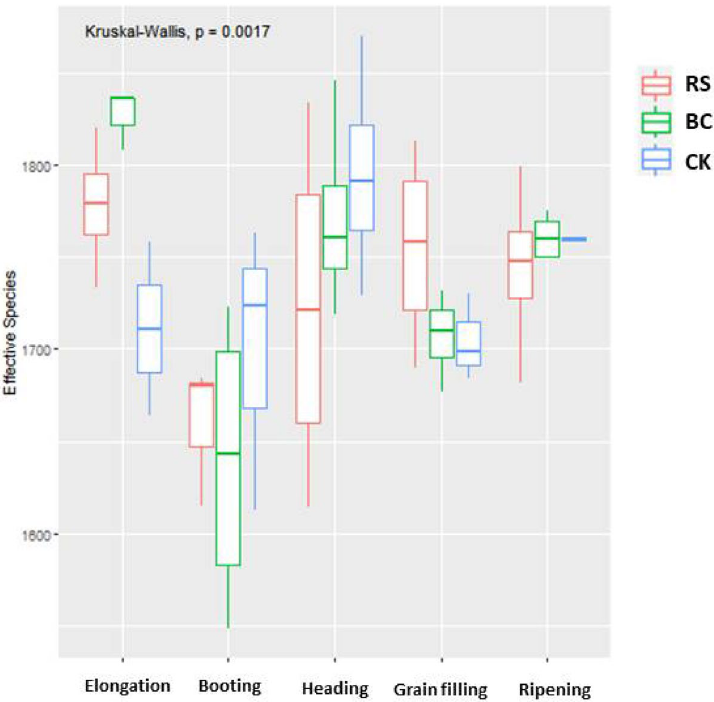
Figure 4. Alpha diversity indices for microbes in rhizosphere soil samples collected during different stages of rice growth. Treatments: RS rice straw applied at 9000 kg ha −1 , BC biochar applied at 3150 kg ha −1 , CK soil without straw/biochar application.